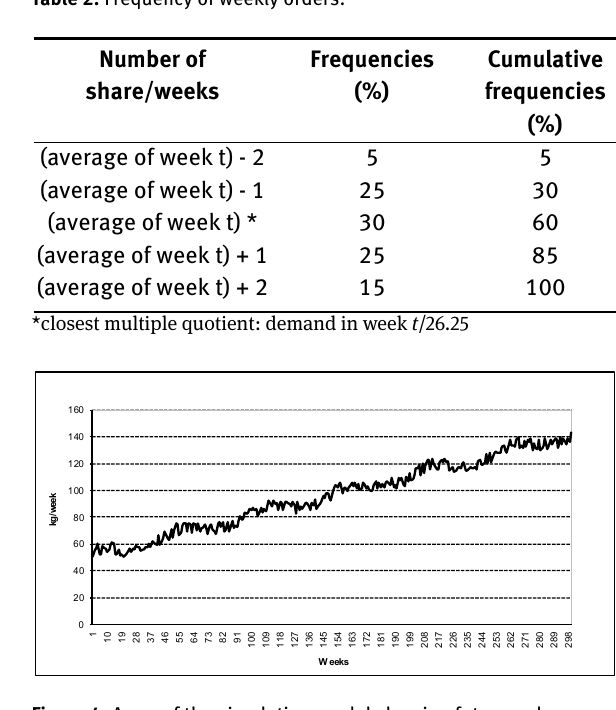
Table 2: Frequency of weekly orders.